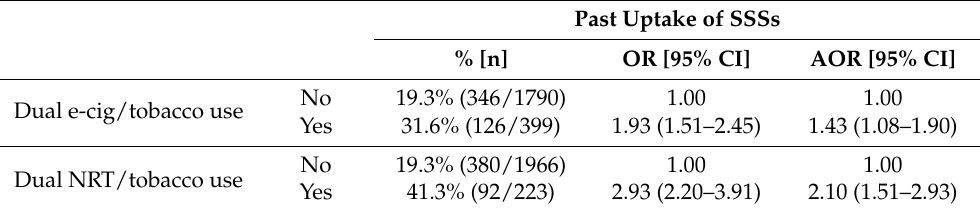
Table 2. E-cigarette or NRT use and past uptake of SSSs amongst current smokers of combustible tobacco.